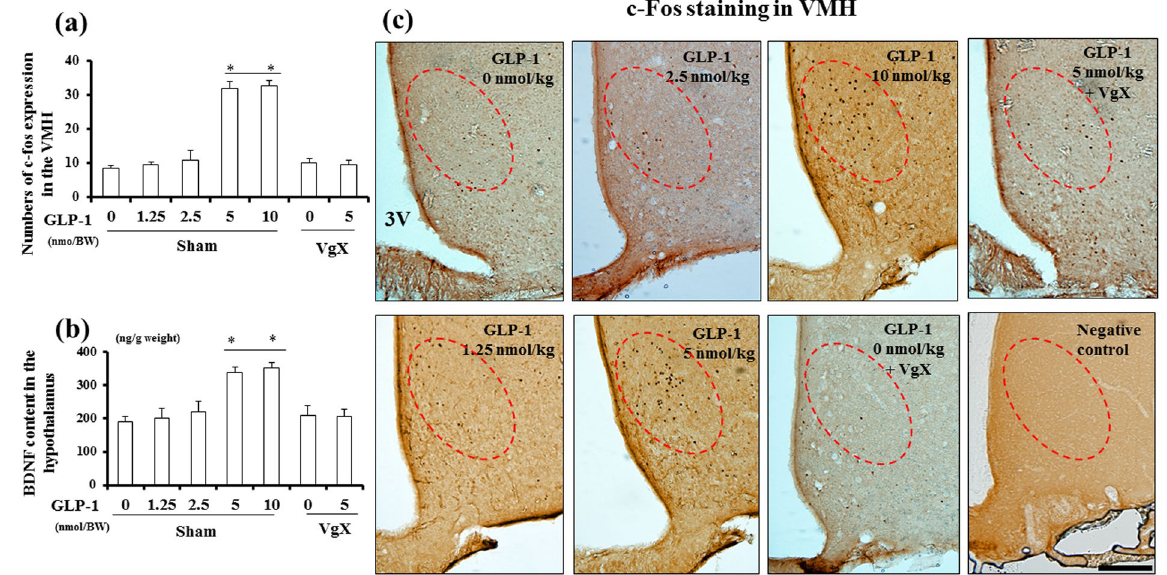
Figure 1. Acute administration of GLP-1 (7–36) at more than 5 nmol/kg BW increases c-fos expression and BDNF content in the hypothalamus through hepatic afferent nerves. ( a and b ) Quantification of c-fos expression in the VMH ( a ) and BDNF content ( b ) in the hypothalamus of each group (n = 6). ( c ) Representative c-fos staining in the VMH of brain sections from each group. Red circle indicates the VMH area in the hypothalamus. * p < 0.05 vs. GLP-1 (7–36) (0 nmol/kg), Treatments: GLP-1; intraperitoneal administration of GLP-1 (7–36), Sham; sham operation, VgX; hepatic afferent vagotomy. 3 V; third ventricle. Scale bar = 100 μ